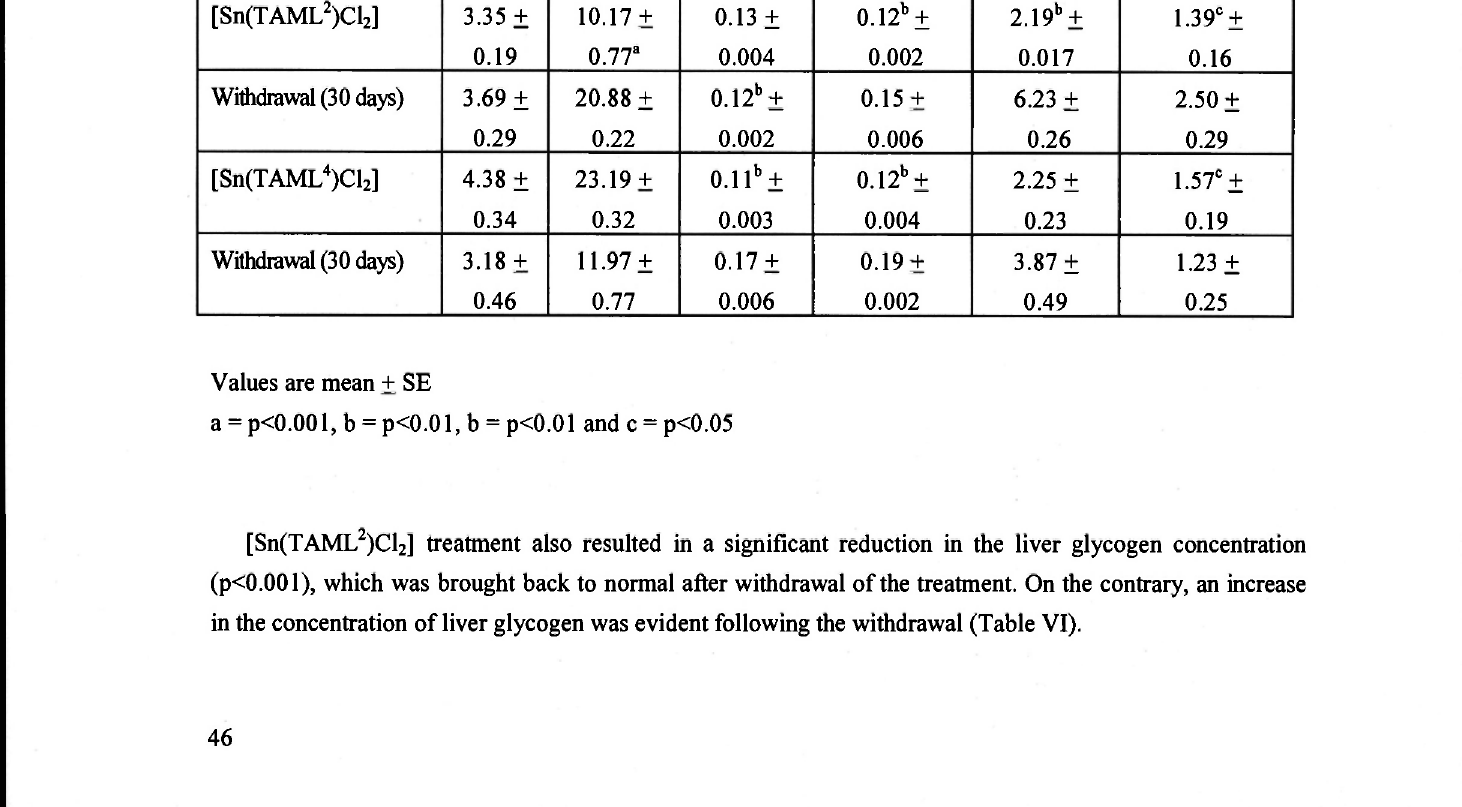
Concentration of glycogen ascorbic acid, acid phosphate and alkaline phosphate of control, Sn(TAML 2 )Cl and [Sn(TAML 4 )Cl ] treated and withdrawal group of 2